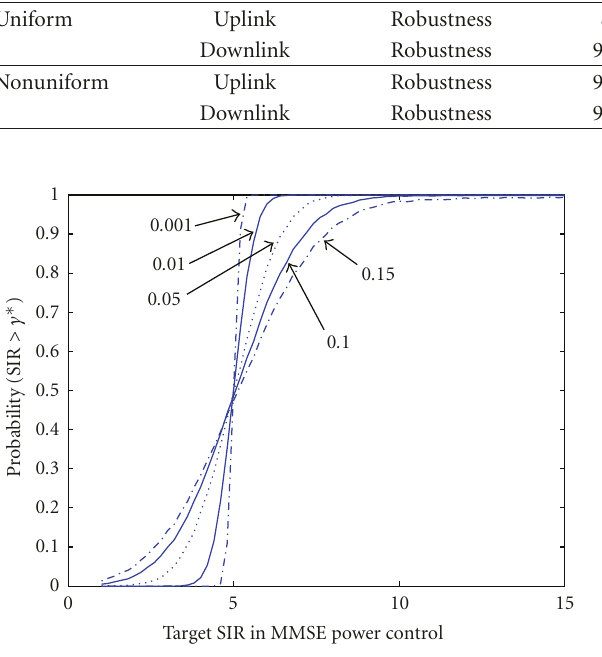
Figure 10: Uplink probability (SIR > γ ∗ ) versus TSIR for Gaussian = 0 . 001,0 . 01,0 . 05,0 . 1,0 . 15 , γ ∗ = 5 . channel estimation error σ 2 h